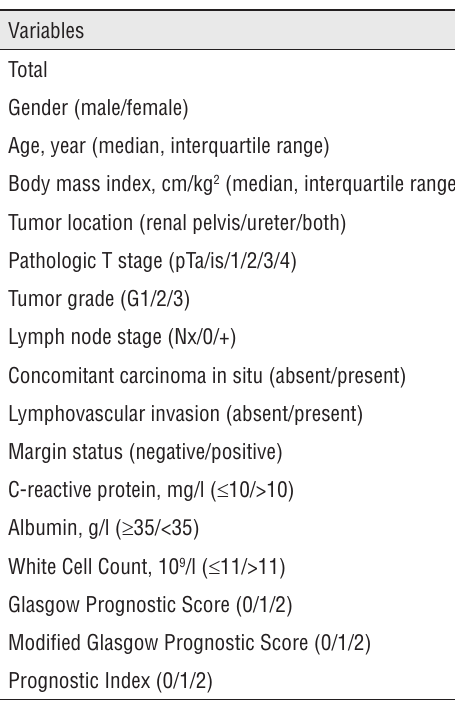
Table 1 - Patient